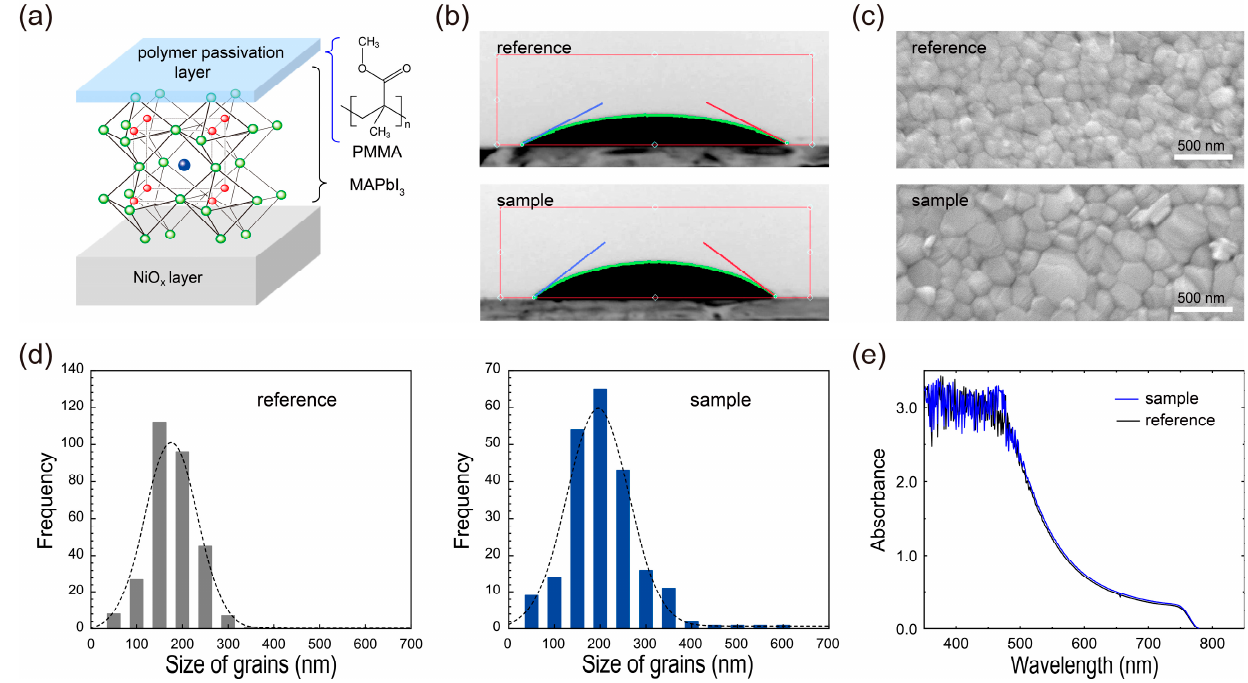
Figure 1. ( a ) Schematic illustration of the polymer passivation layer of PMMA on a MAPbI 3 perovskite layer and corresponding chemical structure. ( b ) Comparisons of the water contact angles on the NiO x /MAPbI 3 perovskite (reference) and NiO x /MAPbI 3 perovskite/PMMA (sample) layers, corresponding to ( c ) high-magnification top-view SEM images and ( d ) grain size distributions derived from the SEM images. ( e ) UV–Visible optical absorption spectra of the reference and sample layers.